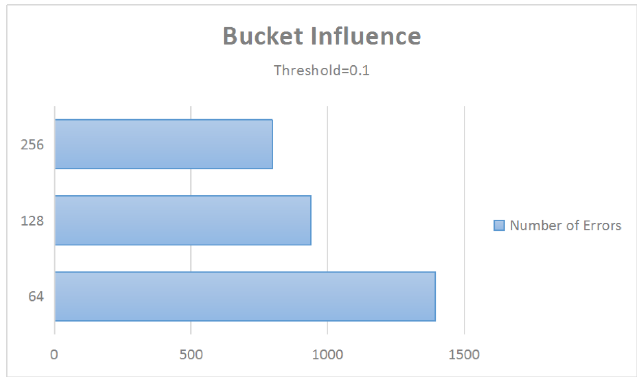
Figure 3. Bucket